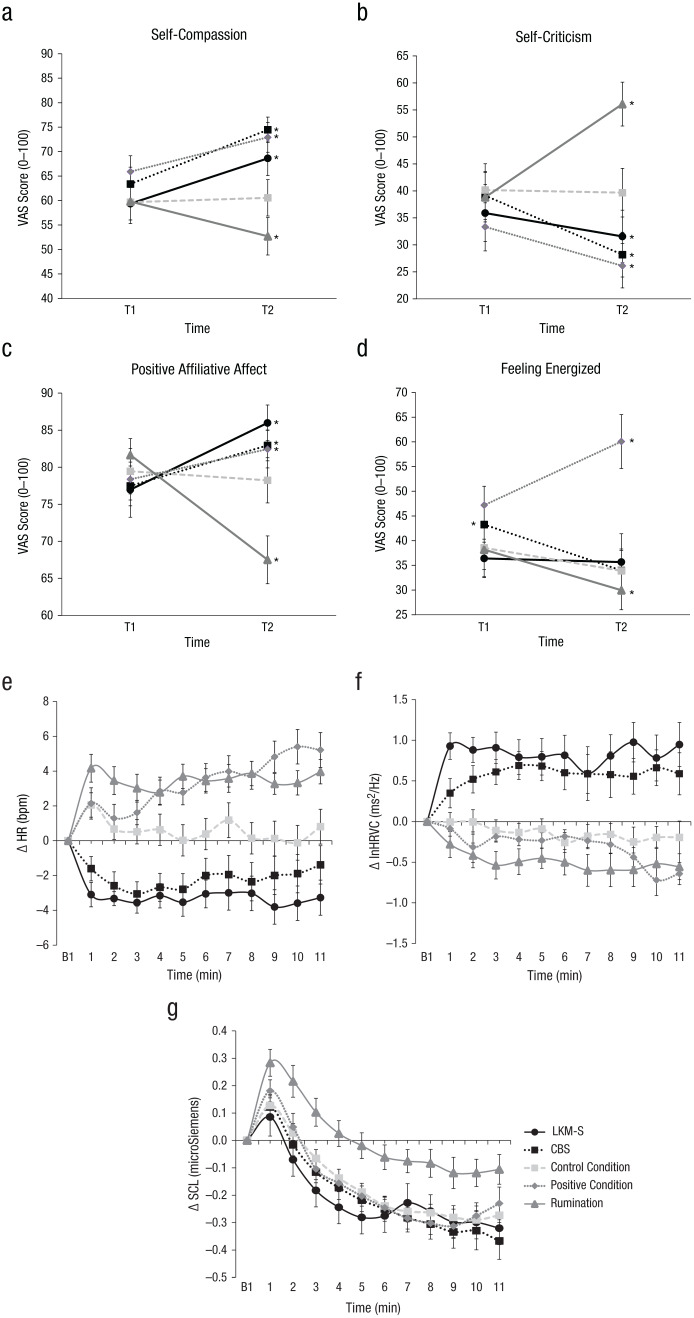
Psychophysiological results for (a) changes in state self-compassion, (b) changes in state self-criticism, (c) state positive affiliative affect, (d) changes in feeling energized, (e) baseline-to-exercise change in heart rate (HR), (f) baseline-to-exercise change in heart-rate variability change (HRVC), and (g) baseline-to-exercise change in skin conductance level (SCL). Asterisks indicate significant change between the preexperimental manipulation (T1) and postexperimental manipulation (T2). Baseline scores for the physiological responses have been set to zero (e.g., we deducted the mean baseline activity from the activity during the exercise). Growth models were run on response scores/baseline-corrected scores. Error bars indicate ± 1 SE. bpm = beats per minute; LKM-S = Loving-Kindness Meditation for the Self; CBS, Compassionate Body Scan.